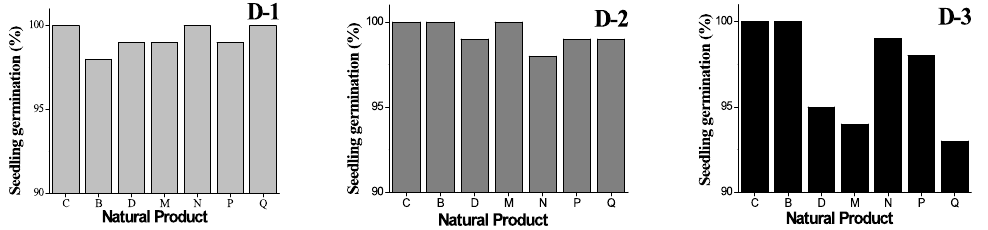
Fig. 1: Seed germination percentage of T. aestivum var. “Kumpa-INIA” with application of BorreGro (B), Dispher Alghum (D), Myconate (M), Natural Green (N), Pow Humus (P), Quick Sol (Q) and control without addition NP (C) at three concentrations: 0.1 mg mL -1 seed -1 (D-1); 1 mg mL -1 seed -1 (D-2), and 10 mg mL -1 seed -1 (D-3). No significant differences were found between values at each concentration using Duncan (P≤0.05). Tab. 1: Plant parameters of T. aestivum var. “Kumpa-INIA” with application of BorreGro (B), Dispher Alghum (D), Myconate (M), Natural Green (N), Pow Humus (P), Quick Sol (Q), and a control (C) without addition NP, at three concentrations: 0.1 mg mL -1 seed -1 (D-1); 1 mg mL -1 seed -1 (D-2), and 10 mg mL -1 seed -1